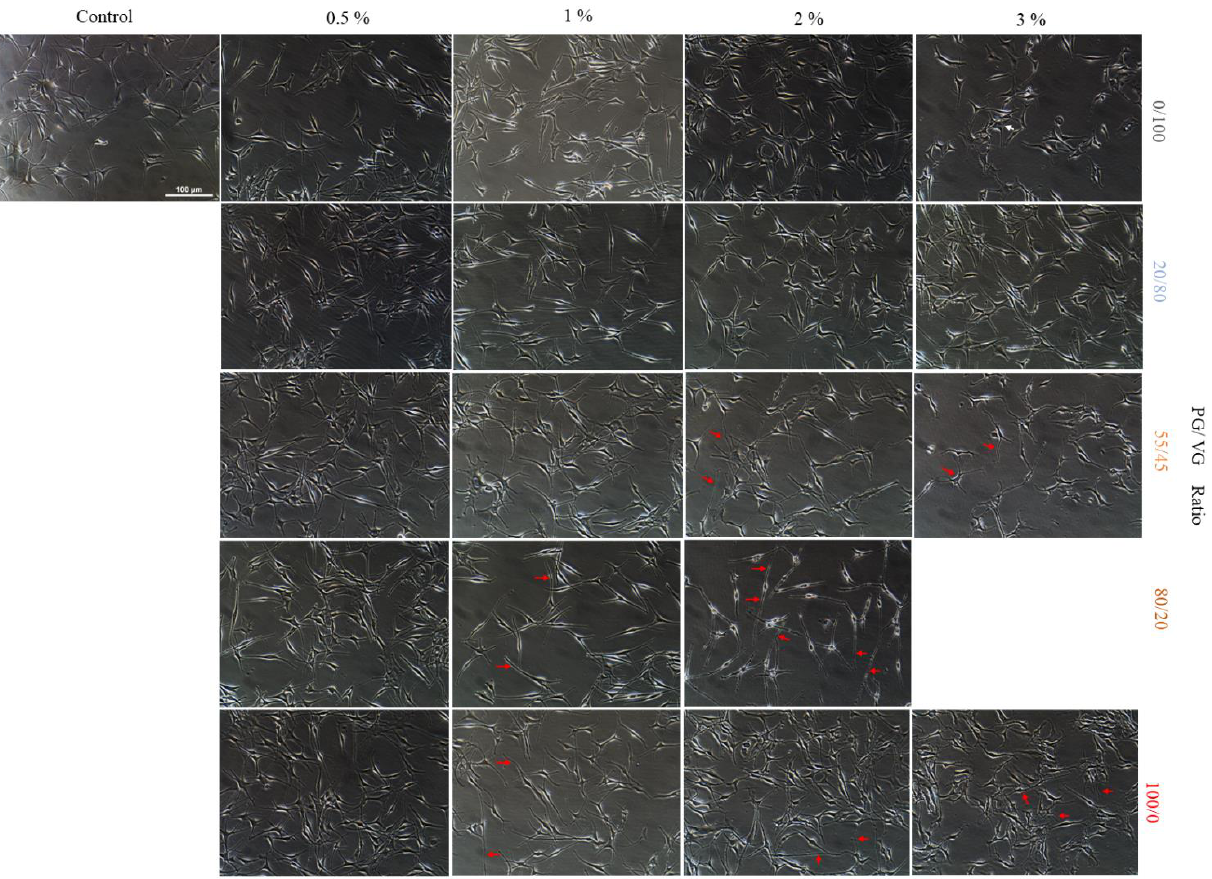
Figure 3. Representative phase-contrast micrographs (20× magnification) of human melanocytes after 48 h exposure to e-liquids containing PG/VG at a ratio of 0/100, 20/80, 55/45, 80/20, and 100/0, each at concentrations: 0, 0.5, 1, 2, 3% v / v ; red arrows in images indicate the extended dendrites of melanocytes in various groups after treatments.